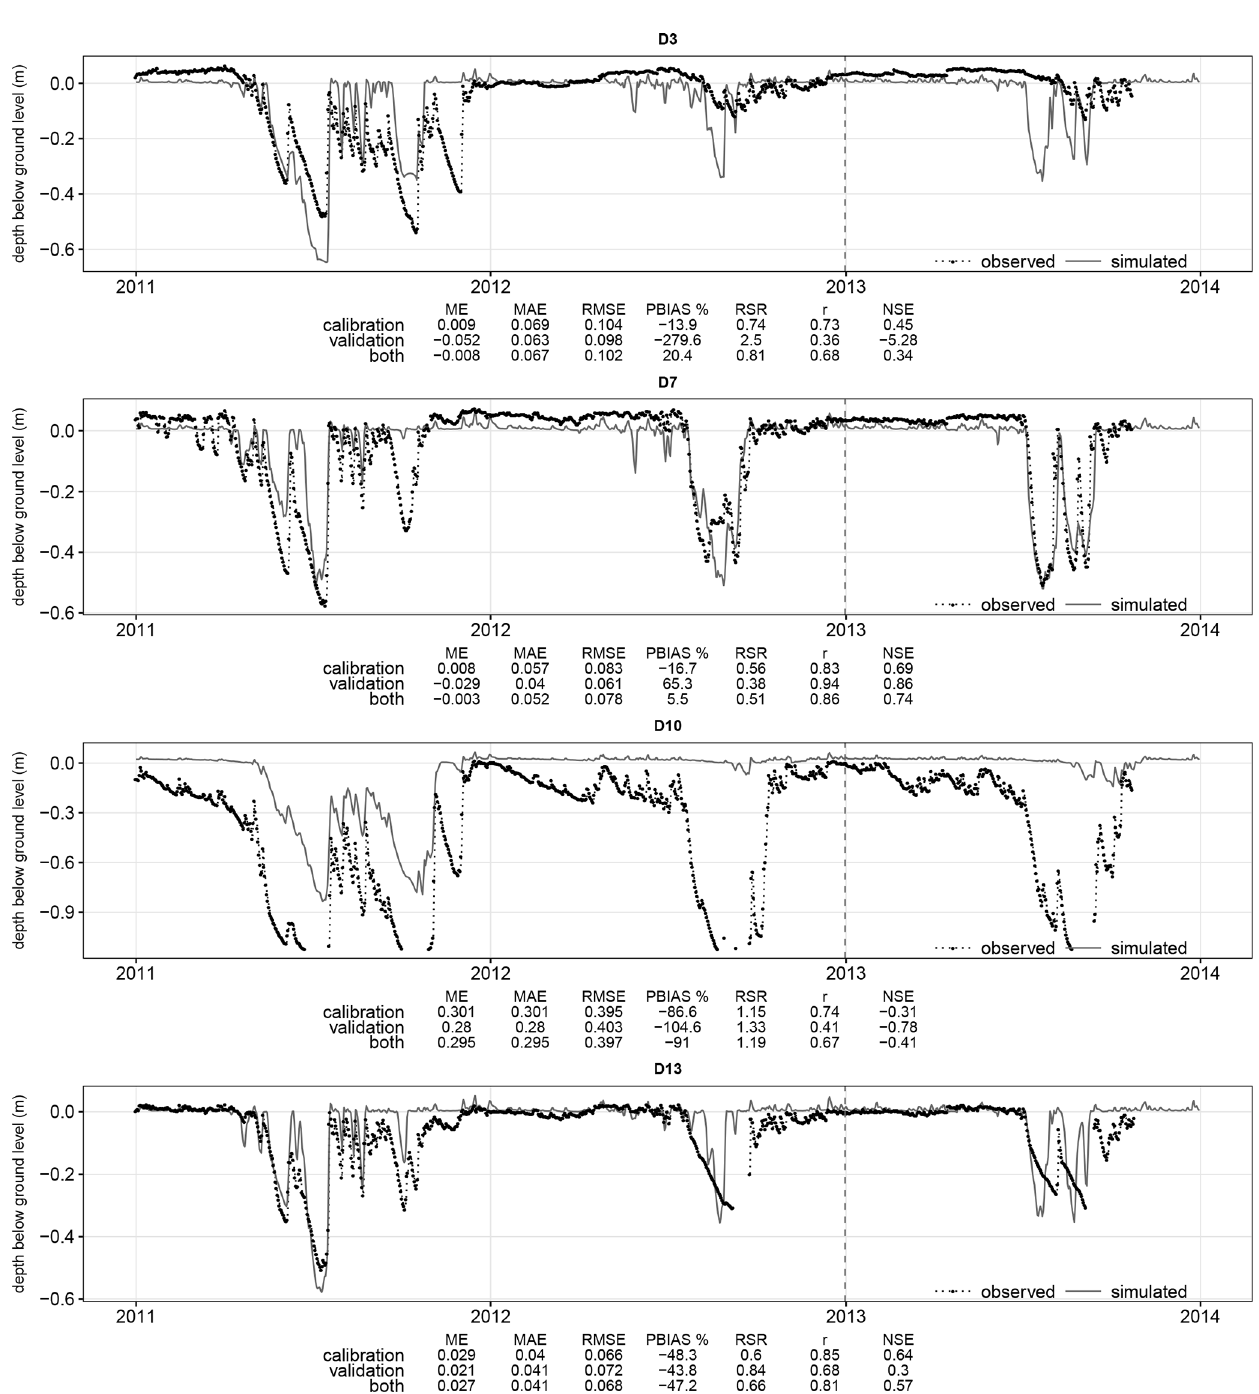
Figure 6. Observed and simulated groundwater table depth and model performance statistics for selected dipwells within the Dauges catch- ment (1 January 2011–31 December 2013). Note different y -axis